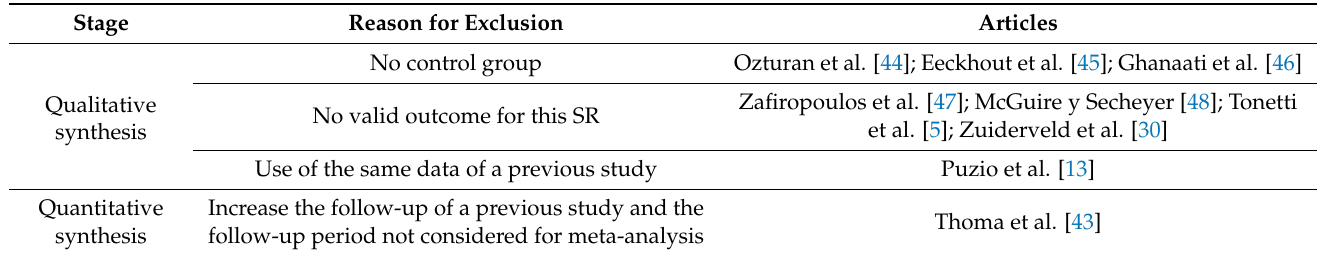
Figure 1. PRISMA flow diagram for studies inclusion process. Table 2. Excluded studies for qualitative and quantitative synthesis with reasons.